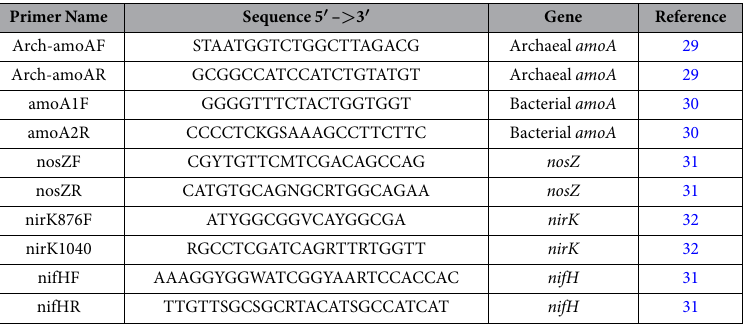
Table 7. Gene specific primers used in this work. The 16S rRNA gene and ITS sequencing primers were the ones described by the manufacturer (Illumina Inc.) for the metagenomic library preparation guide # 15044223-b.